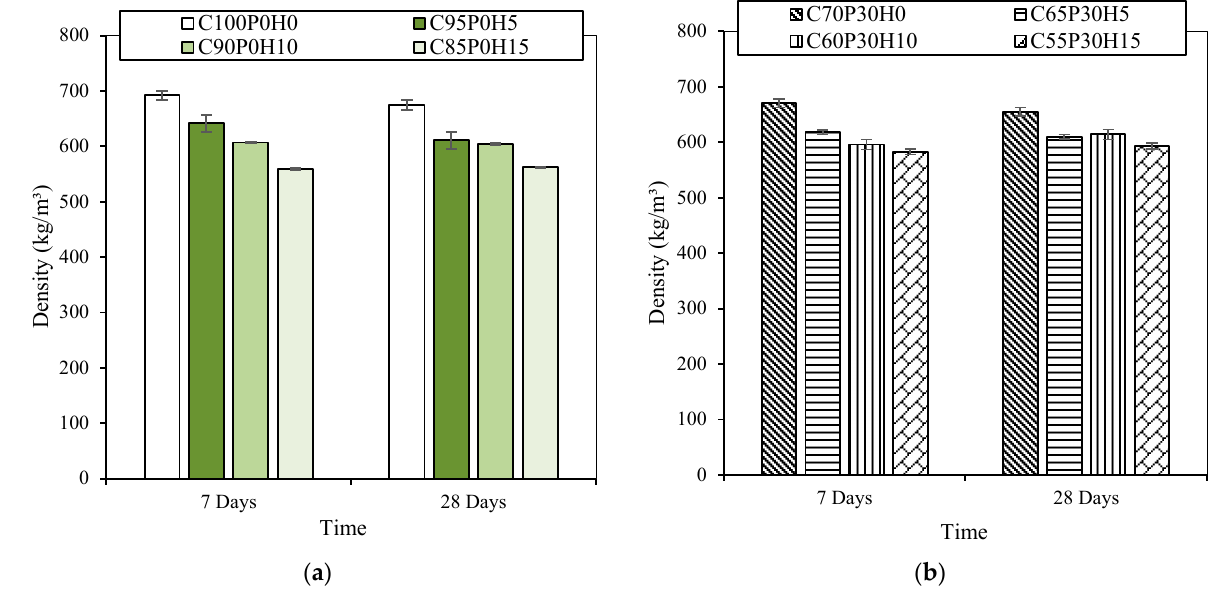
Figure 2. Density of all samples against time for ( a ) C100-BFCs and ( b ) C70-BFCs. Density decreased regularly and by approximately 7% as the hemp shiv content